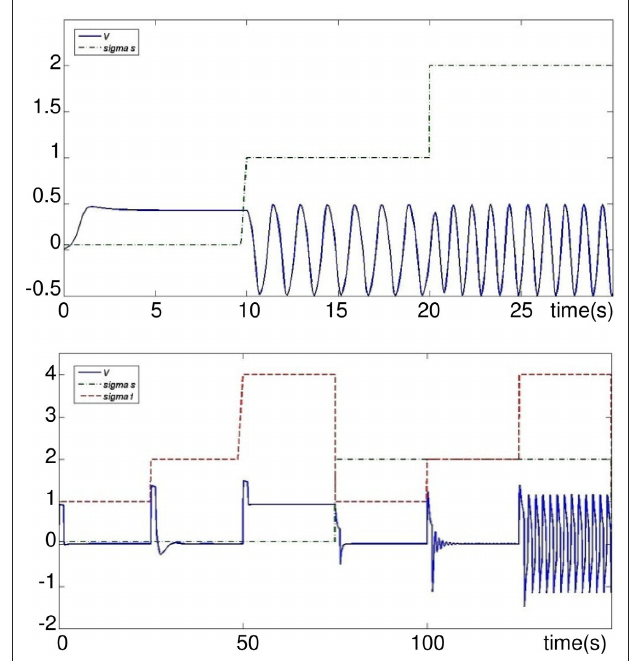
FiguRe 2 | Activity mode and frequency w.r.t different values of σ Top: σ = 2.2 and σ f and σ ∈ [1,2,4]. I f